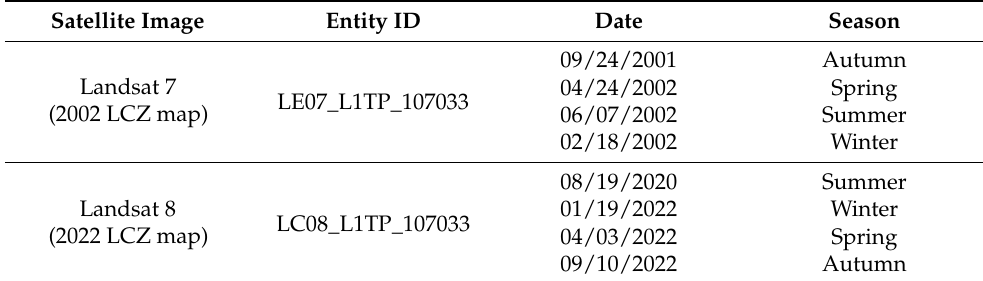
Table 4. Satellite images for creating LCZ maps.